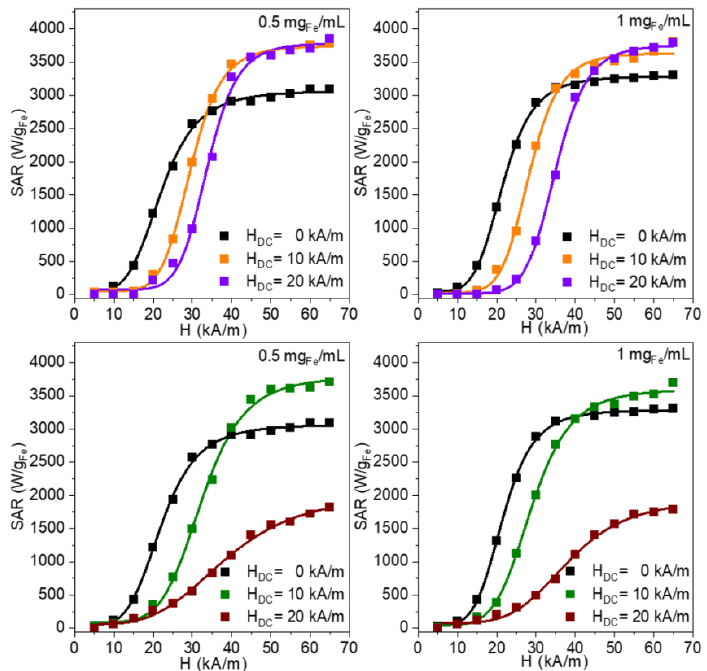
Figure 4. SAR dependence on the H for both parallel (upper panels) or perpendicular (lower panels) orientations of the H DC (20 kA/m) to the AMF lines for the Zn ferrites dispersed in water in the concentration of 0.50 and 1.00 mg Fe /mL. For comparison, the SAR dependence on the H for all samples, in zero H DC and H DC of 10 kA/m, is also